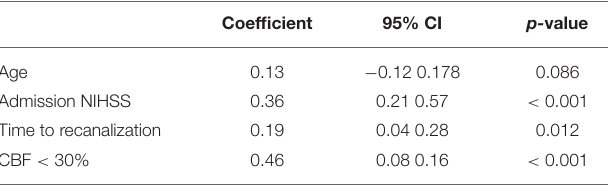
TABLE 2 | Linear regression coefficients for the variables assessed in the prediction model. Coefficient 95% CI p- value